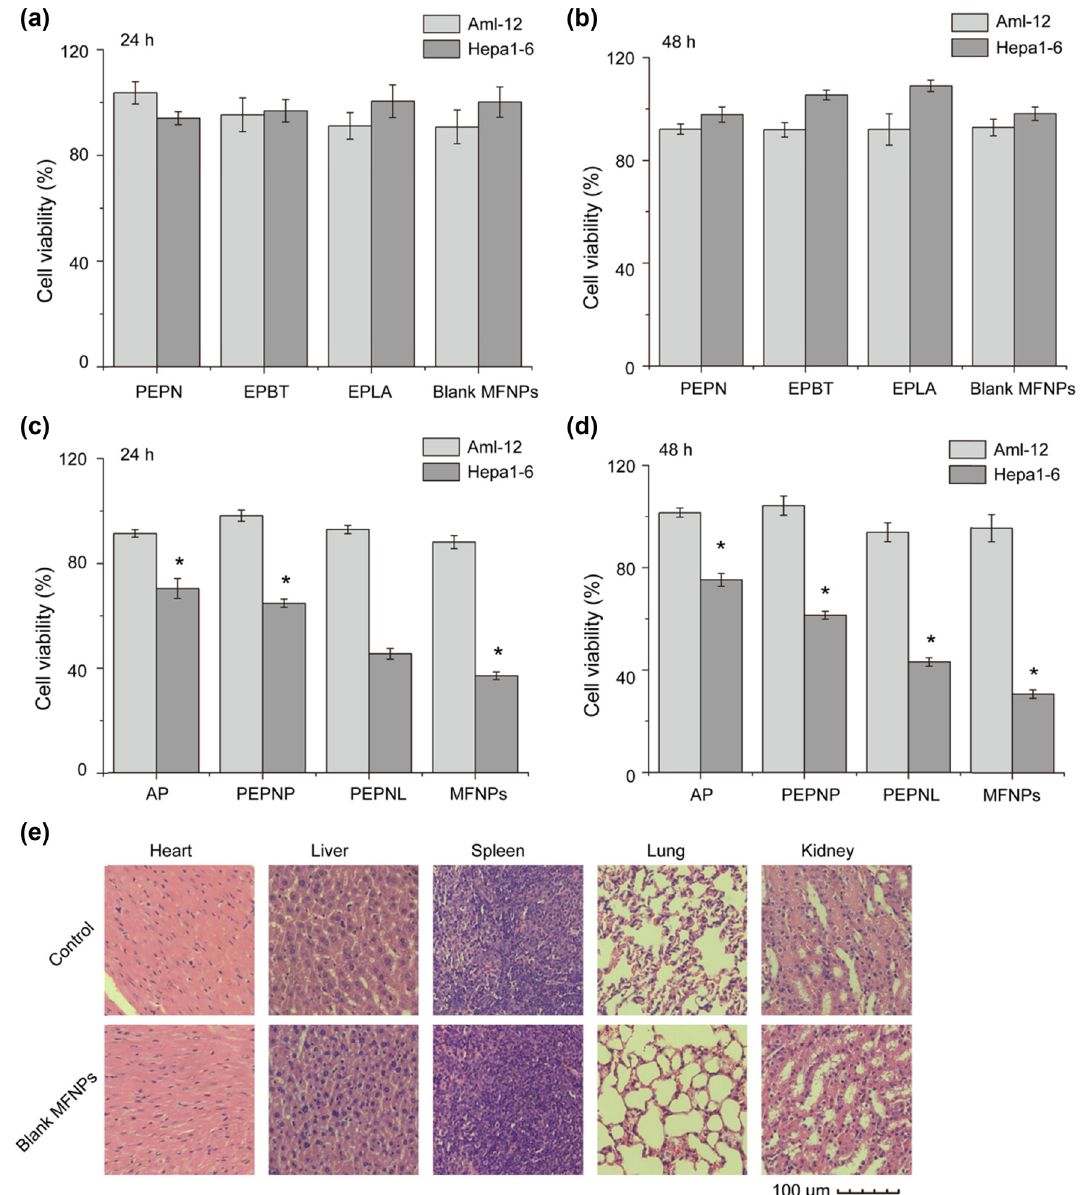
Figure 2: Cell viability of PEPN, EPBT, EPLA, and blank MFNPs at ( a ) 24 h and ( b ) 48 h. Cell viability of free AP, PEPNP NPs, PEPNL NPs, and MFNPs at ( c ) 24 h and ( d ) 48 h. ( e ) H&E stained tissue sections of BALB/c nude mice after injection of blank MFNPs ( 24 mg · kg − 1 ) via the tail vein. Data are presented as mean ± SD ( n = 6 ) , and statistical analyses were performed using a two - sided Student ’ s t - test ( * p < 0.05, ** p < 0.01, *** p < 0.001 )